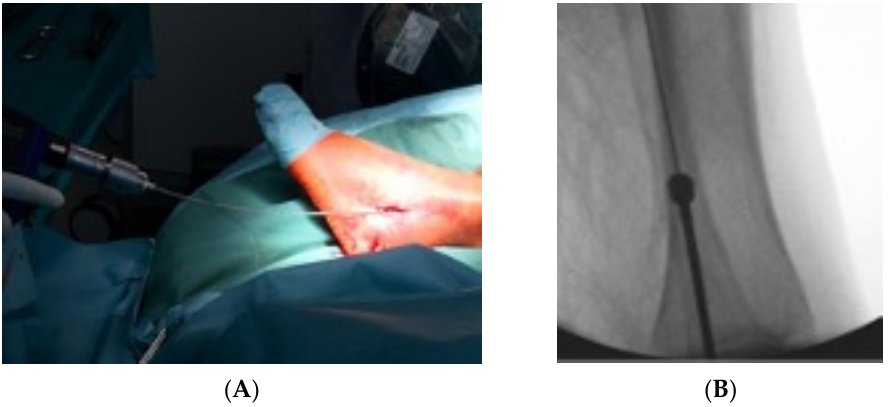
Figure 3. In ( A ) the 1 mm stepwise reaming with a minimum diameter of 4.5 mm is shown with the corresponding intraoperative fluoroscopic image of the reaming procedure ( B ).